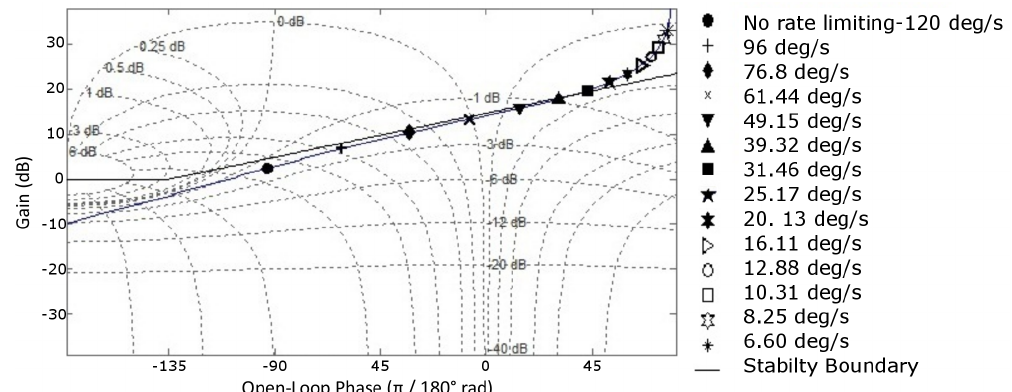
Figure 8. OLOP analysis result for “Phastball”